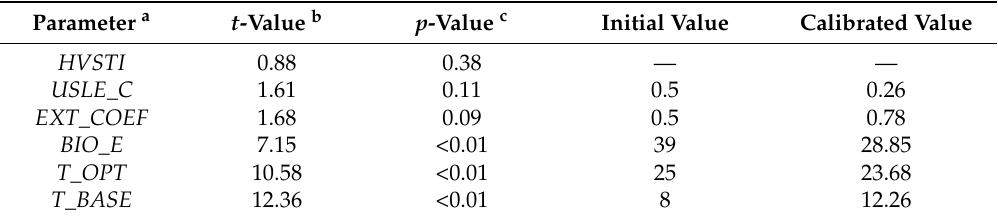
Table 6. Global sensitivities of the parameters that affect shoot dry matter.